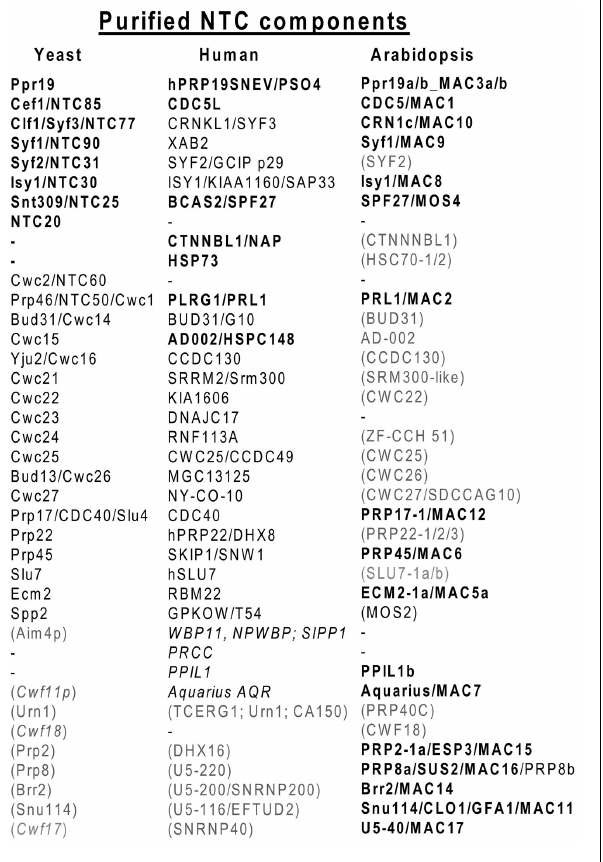
FIGURE 3 | Conserved components of NTC core and associated subunits detected in purified yeast, human, and Arabidopsis complexes. Proposed NTC core subunits are highlighted in bold, brackets indicate factors that are not present in purified NTC complexes but encoded by corresponding homologous genes in the yeast, human, and Arabidopsis